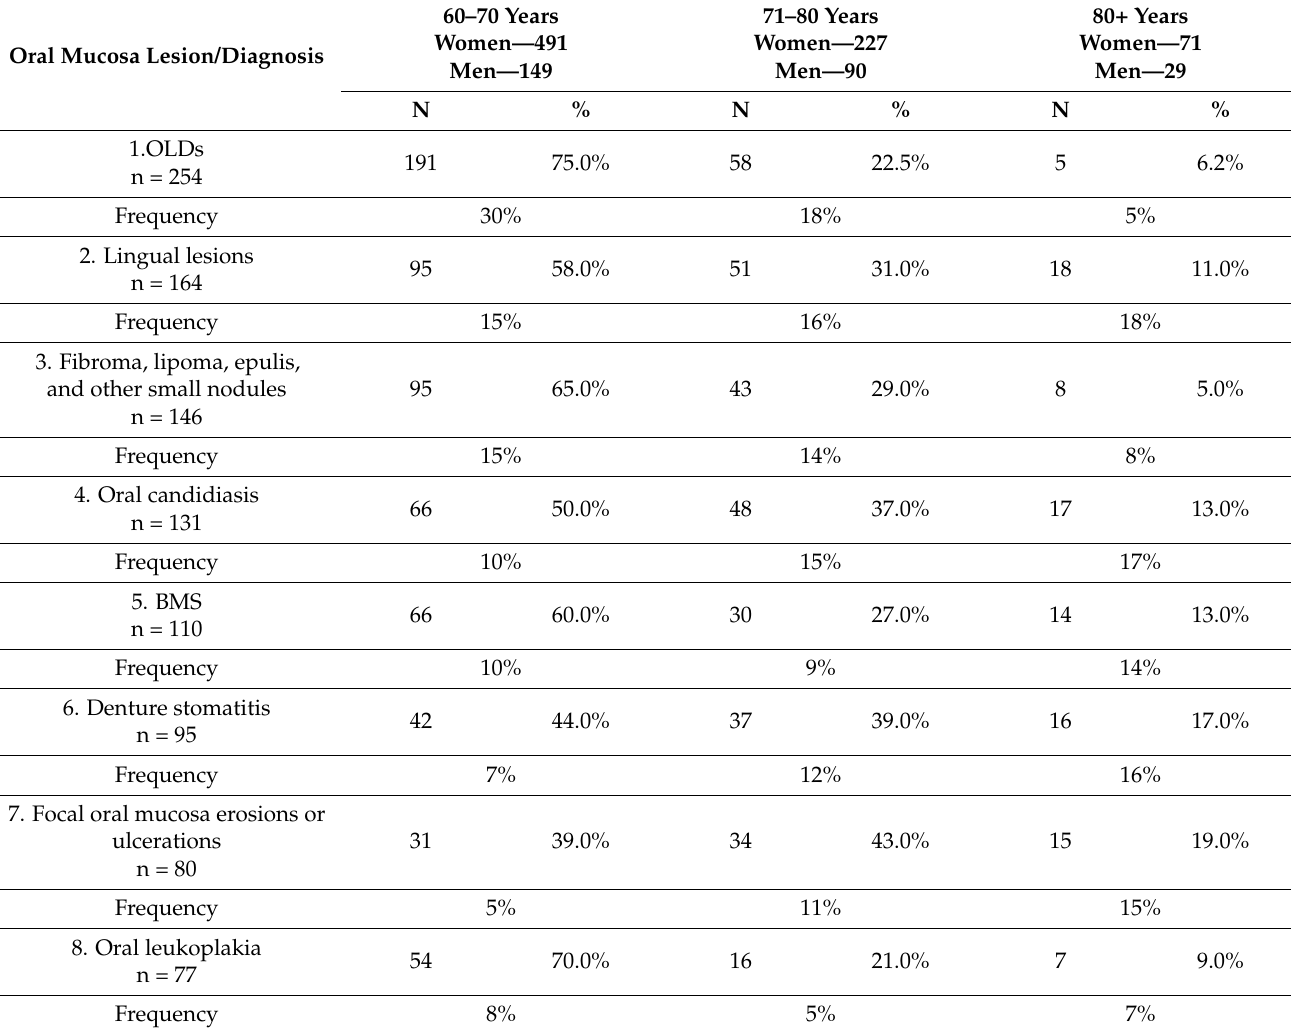
Table 4. The frequency of oral mucosa lesions in the three age